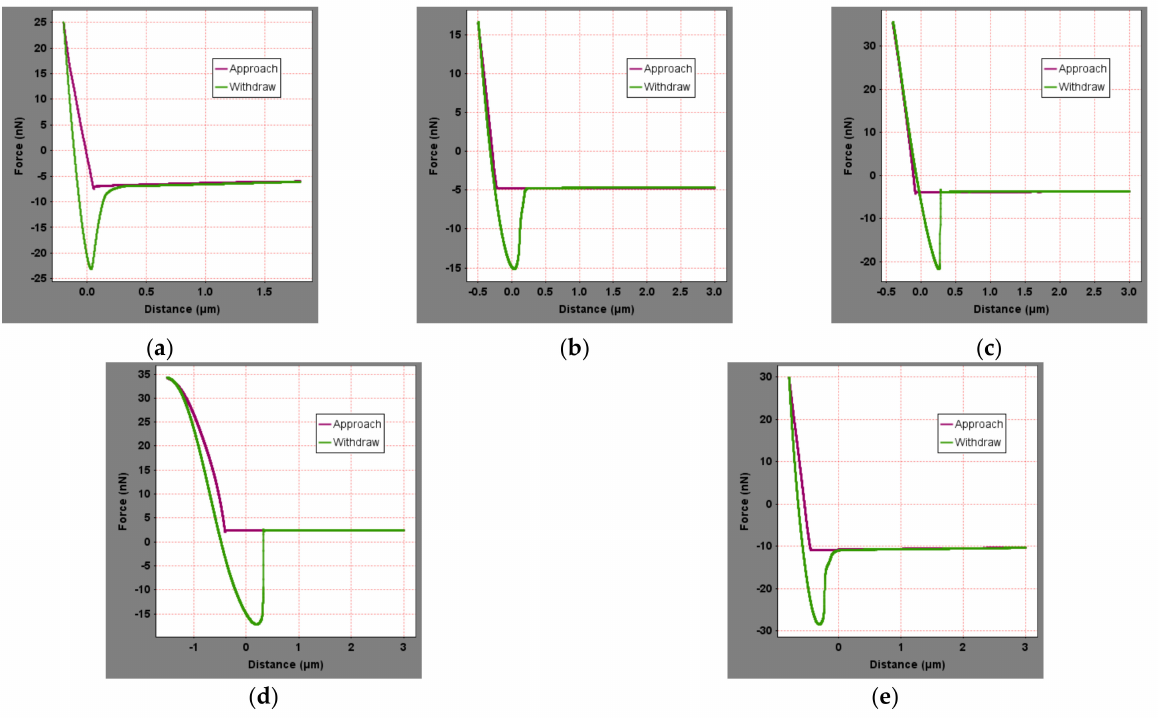
Figure 12. Force curves of asphalt binder doped with anti-stripping agent: ( a ) SK-70, ( b ) KL-70, ( c ) Shell-70, ( d ) SK-90, and ( e )